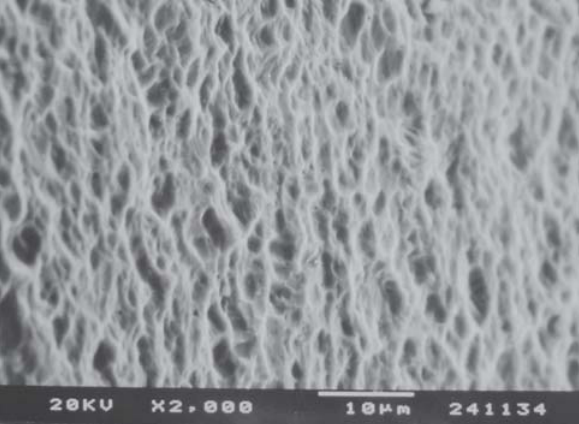
FIGURE 1- Implant not submitted to the action of fluoride ions F(-) 2000x